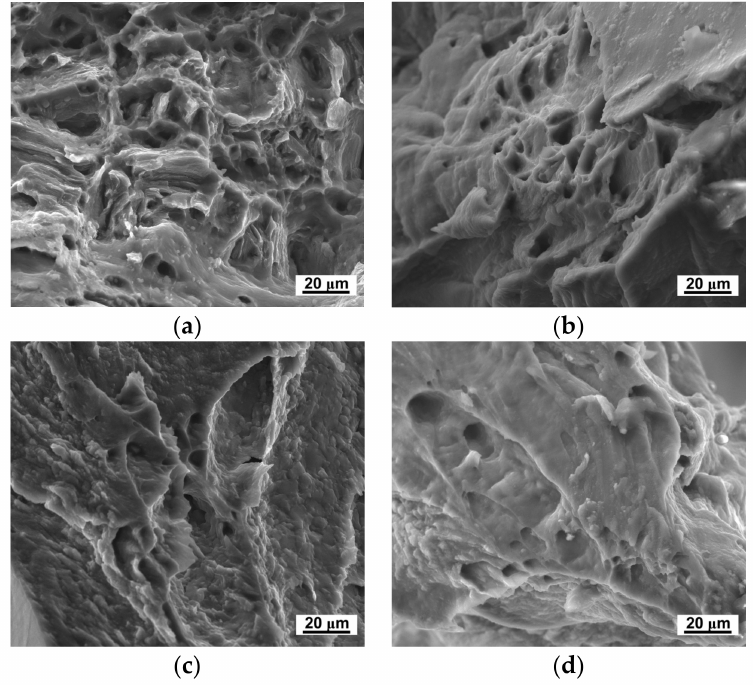
Figure 10. Micro-tensile fracture morphology of the original LZ91 alloy at temperature of ( a ) 298 K; ( b ) 373 K; ( c ) 423 K; and ( d ) 473